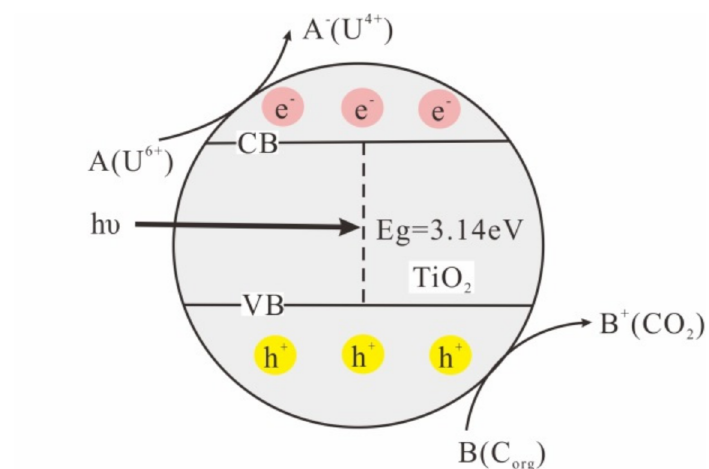
Figure 7. The mechanism of TiO 2 photocatalytic reduction of uranyl ions (modified after